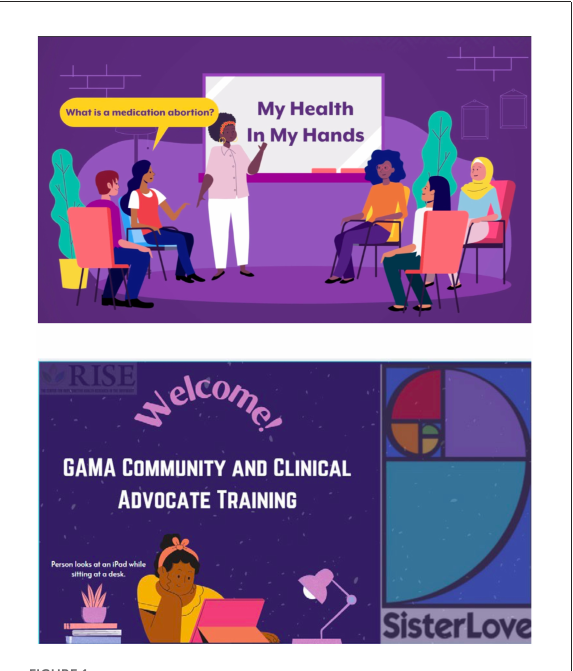
FIGURE1 My health in my hands medication abortion psychoeducational video and the community-clinical advocacy